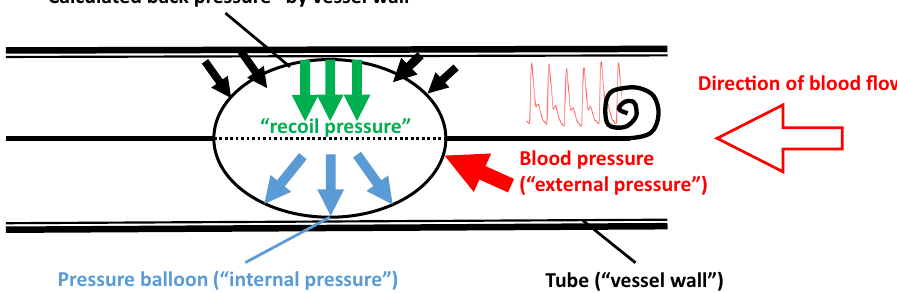
Figure 2. Schematic drawing of forces and resulting pressures. As long as there is no wall contact, the internal pressure in the balloon arises from elastic recoil forces of the balloon and the surrounding, external blood pressure. Once the balloon is wedged in the vessel/tube, the internal balloon pressure results from the elastic recoil forces of the balloon, the external blood pressure, and the calculated back pressure of the surrounding